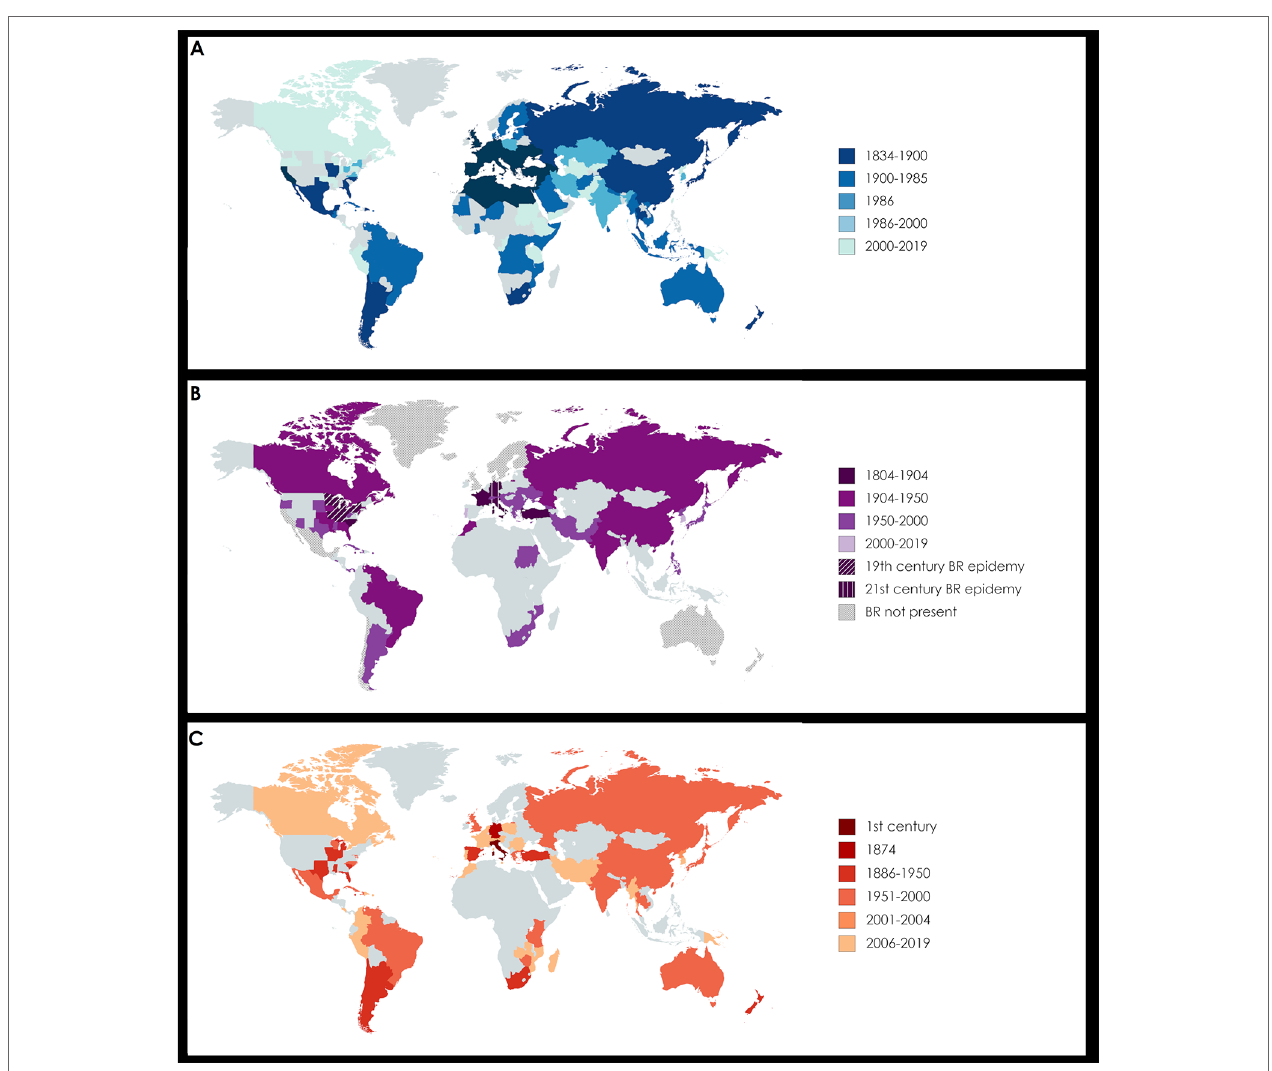
FIGURE 1 | Worldwide diffusion of powdery mildew (PM, panel A), black rot (BR, panel B), and anthracnose (AN, panel C). The relative bibliographic sources are reported in Table S1 . (A) PM was first reported in northeastern America in 1834 by Schweinitz. In 1845 it was introduced in Europe and less than 10 years later was affecting all the wine producing country of the Mediterranean region. In 1986, Amano published an outstanding review listing the countries all over the world where fungi causing PM were present at that time in relation with their specific plant hosts, including grapevine. Today PM can be considered a “worldwide grapevine disease”, since it afflicts vineyards all over the world. (B) BR is native of northeastern America. In 1804 it was noticed in Dufour’s vineyard (Kentucky) and it became epidemic in the second half of the 19th century in all the Great Lake Region, where the entire yield in many fields was lost. The first occurrence in Europe was recorded in 1885 by Viala and Ravaz in Southern France, then it spread all around the world, although without a huge economic impact. In 1989, BR showed an increasing presence in Switzerland, but it was in the 21th century that a second outbreak afflicted Europe, starting from Germany, where the economic losses were severe, to the Alps area (Ticino, Switzerland; Friuli and Veneto, Italy), Hungary and Romania. Regions with an unfavourable climate, as Scandinavia for cold and Mexico for dry weather, are considered BR “free” today. Interestingly, also in Australasia and Chile BR remains absent. (C) AN is considered one of the oldest known plant disease, since reference to it were reported in ancient Rome by Theophrastus (in De causis plantarum ) and by Pliny the Elder (in Naturalis historia ), dating back to the first century of the Christian era. Its European origin was also confirmed by the first report of the modern era in 1874 by De Bary, in Germany. AN diffusion was not alarming until its arrival in Tropical areas, such as South America. Nowadays AN is again becoming a threat in Europe.